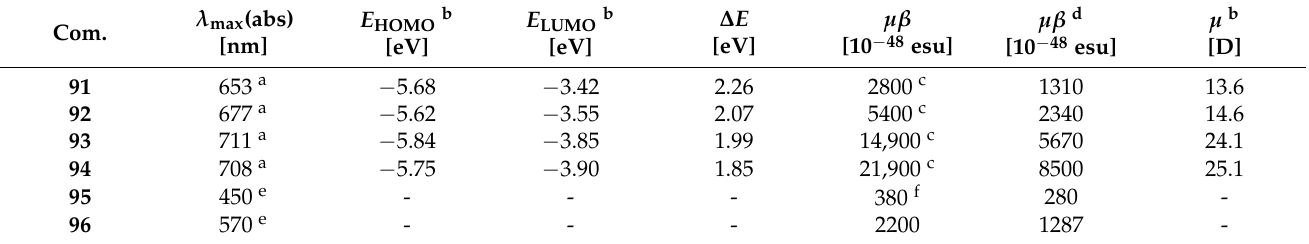
Table 10. The (non)linear optic and electronic properties overview of derivatives 91 – 96